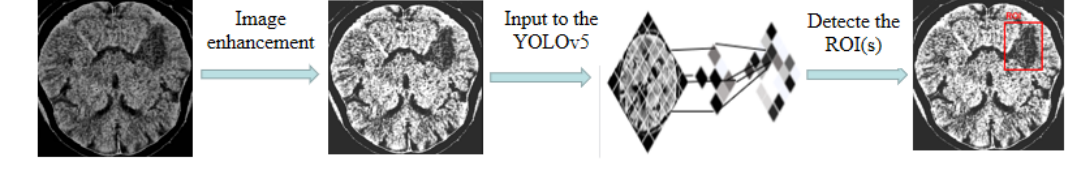
Figure 2. The structure of AC ‐ YOLOv5.